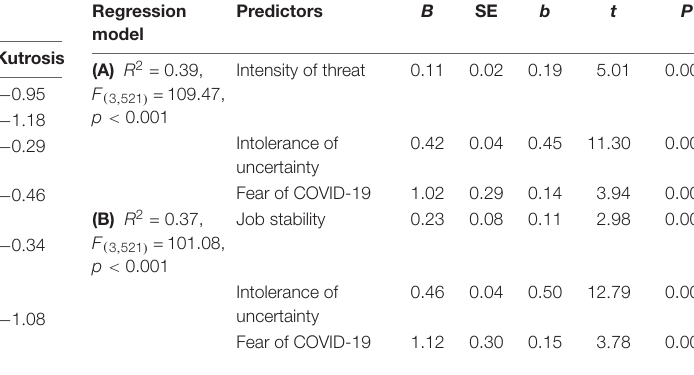
TABLE 4 | Two regression models with different PJIS predictors: (A) Intensity of threat and (B) Job